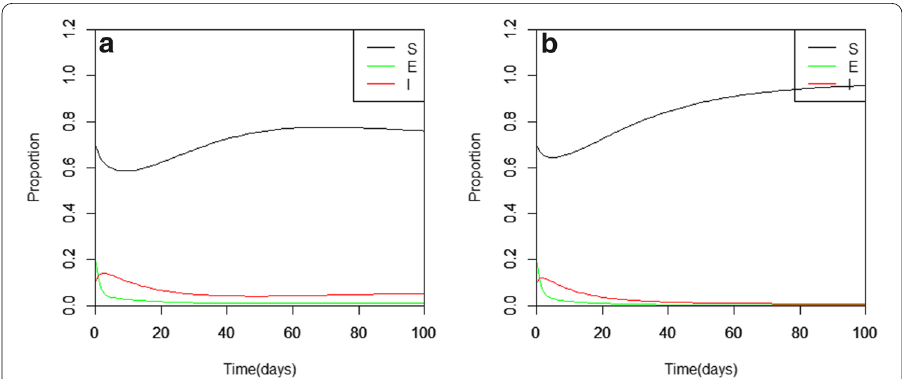
Fig. 4 The latent infection SEIR model with direct transmission effects where β = 0.433 ( a ) and β =